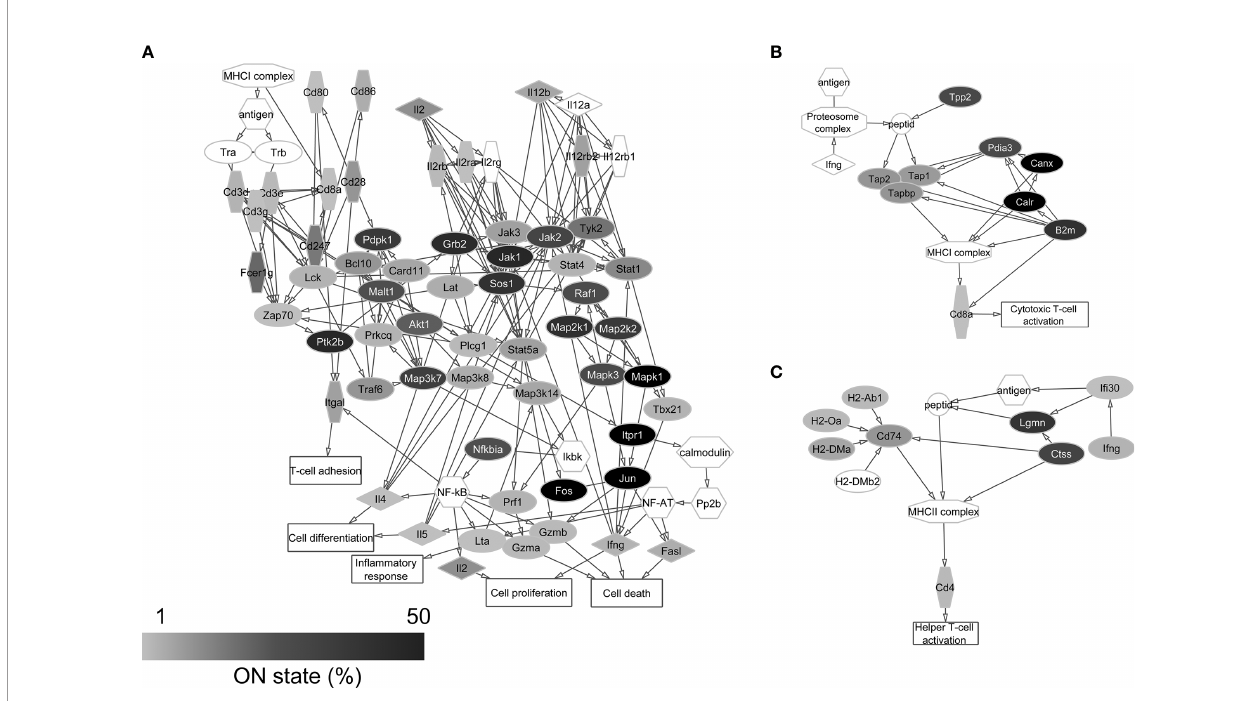
FIGURE 3 | Protein-protein interaction networks of CD8+ T cell activation (A) , MHC class I (B) , and MHC class II (C) antigen presentation. Gray scale shows the percentage of neurons that expresses the transcript of each protein in the single-cell sequencing data (ON state frequency). The transcripts of proteins with white label were not found in the sequenced neurons. It can be seen that mainly signaling protein genes of primary importance are expressed in the majority of